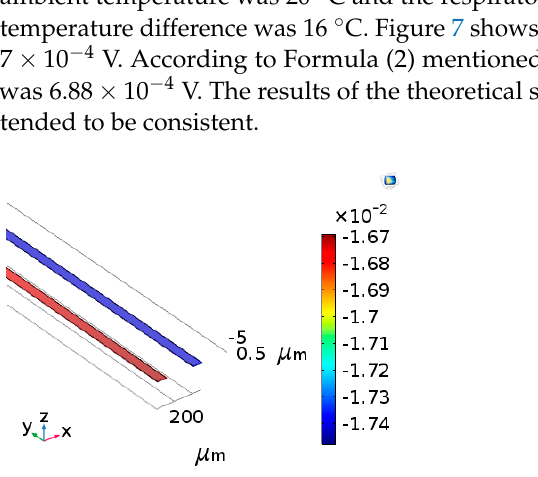
Figure 8. Temperature change of the hot junction at different thermocouple thicknesses. Table 1. Response of the thermocouple with different thickness. Thickness of Thermocouple (nm)